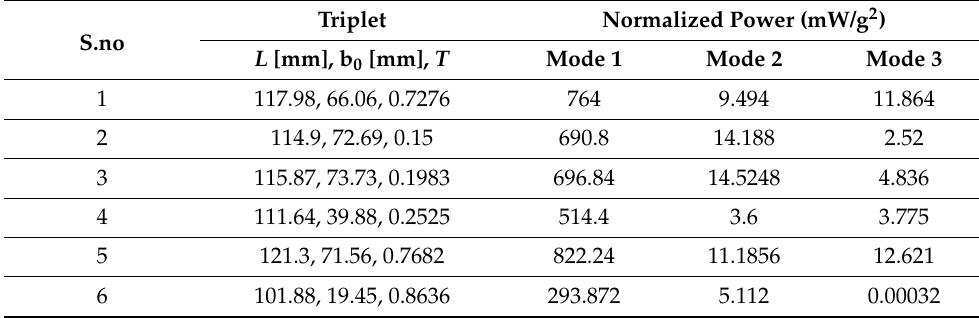
Table 6. Comparison of optimal parameters presented in Table 4 under acceleration of 0.5 g.